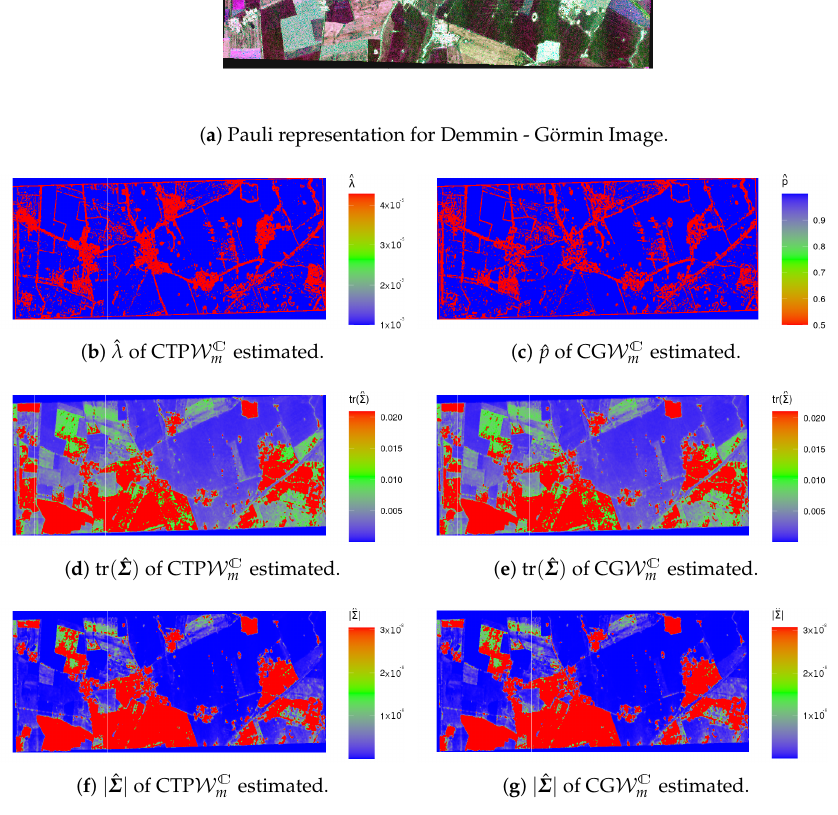
Figure 7. Maps of estimated parameters of CTP W C m ( left ) and CG W C m ( right ) distributions,